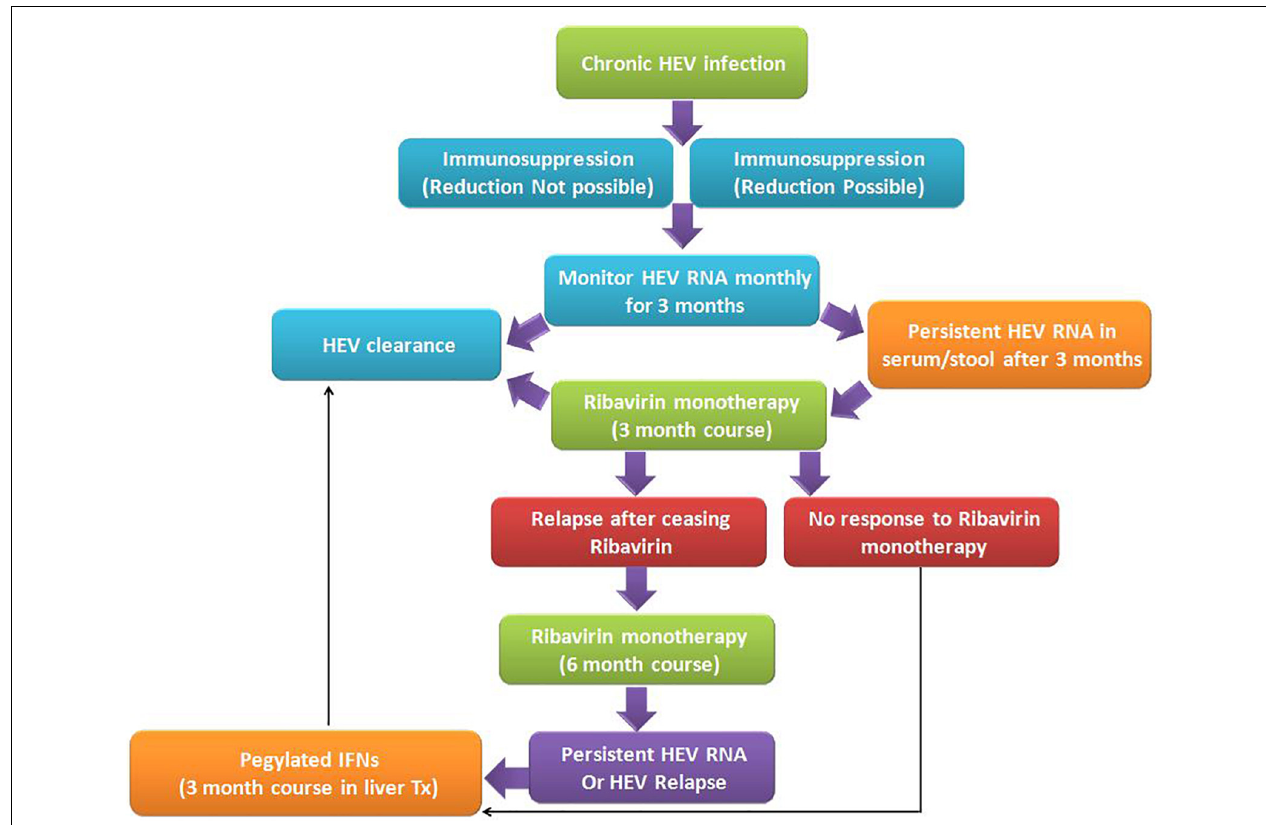
FIGURE 5 | Algorithm for management of chronic hepatitis E viral infection: Chronic HEV infection in immunosuppressed patients is very common due to immunosuppressed state, wherever possible immunosuppressive doses need to be modulated as per the chronicity of the disease. However, in both the states, if HEV RNA persists for more than 3 months in serum and/or stool, ribavirin monotherapy for 3 months duration is the recommended treatment regimen. Such patients on treatment may be either non-responders to ribavirin therapy or clear the virus post-therapy. In a few cases, after ceasing the ribavirin therapy, relapse does occur, which is further treated with extended 6 months ribavirin monotherapy. Individuals who are non-responders or cases with HEV relapse, administration of pegylated interferon helps in the clearance of HEV viral infection and recovery of patients (Dalton et al., 2018).